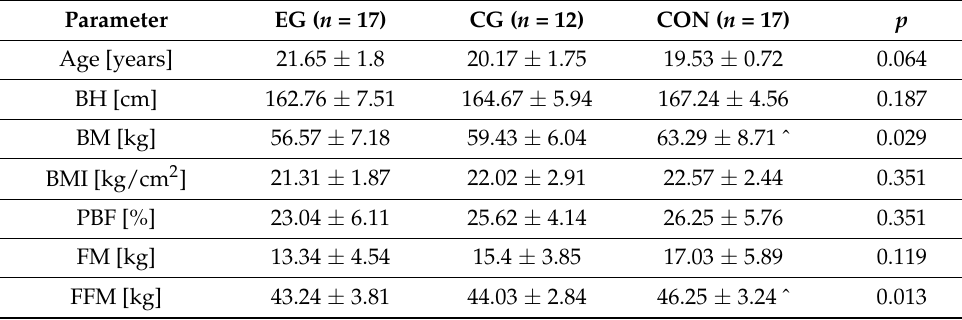
Table 2. Characteristics of the subjects.